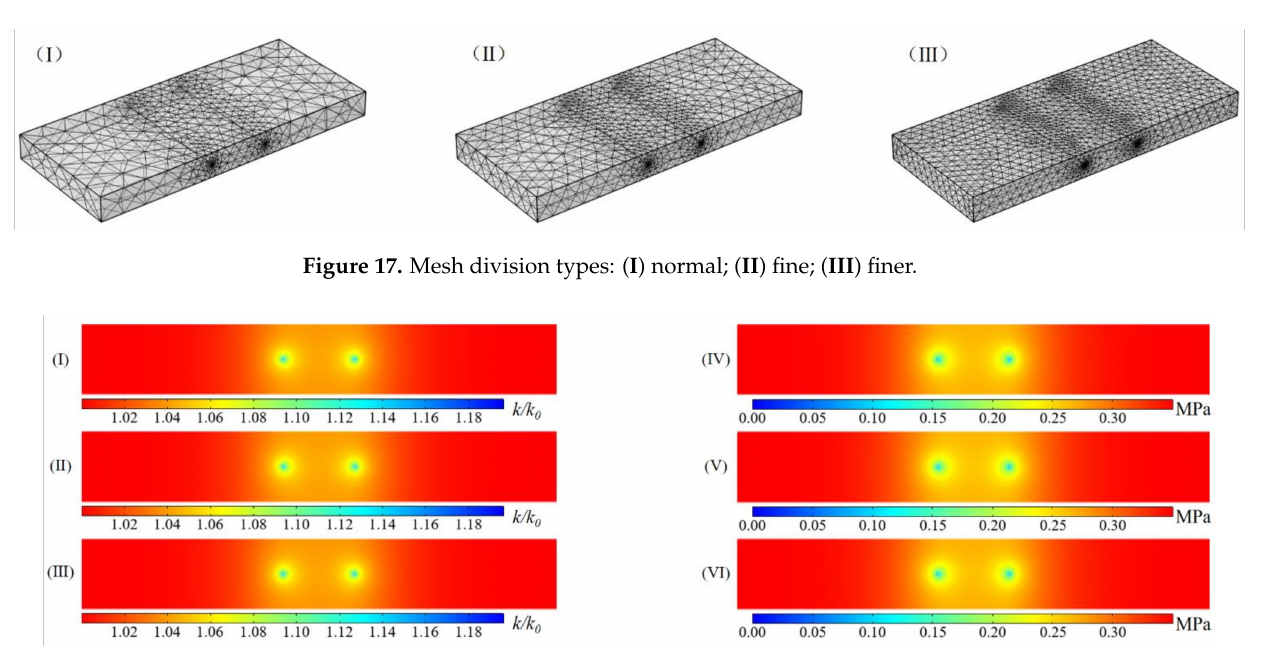
Figure 18. Cloud chart of permeability and gas pressure distribution of different mesh types at 10 d of drainage: ( I – III ) are the permeability distribution of mesh type from normal to finer; ( IV – VI ) are the gas pressure distribution of mesh type from normal to finer.